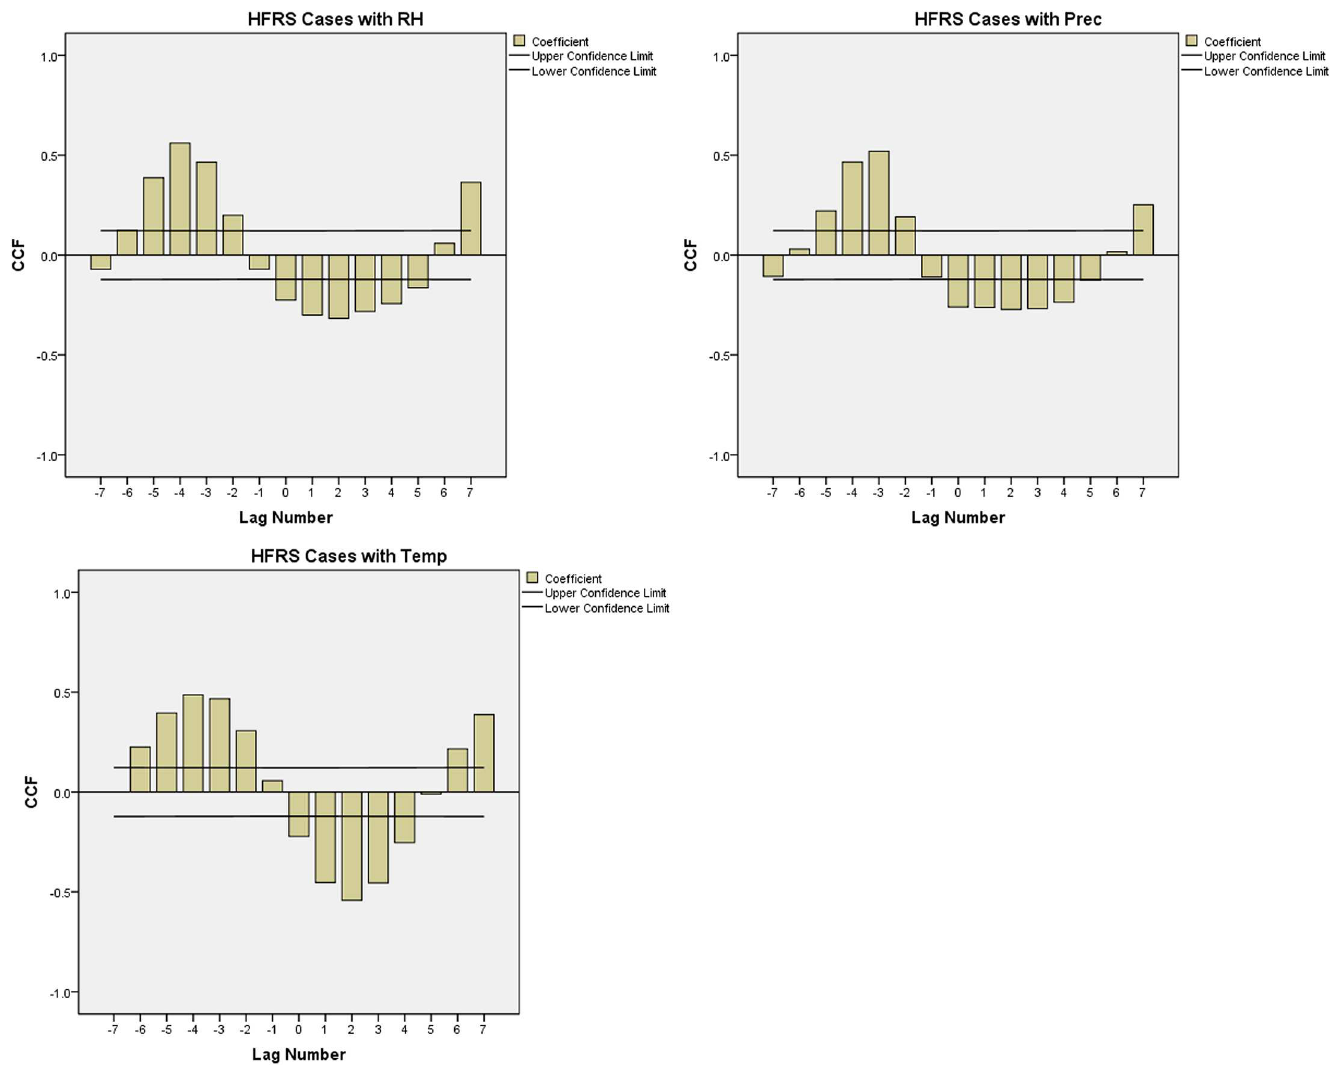
Fig 4. Cross-correlation analysis between HFRS cases and meteorological